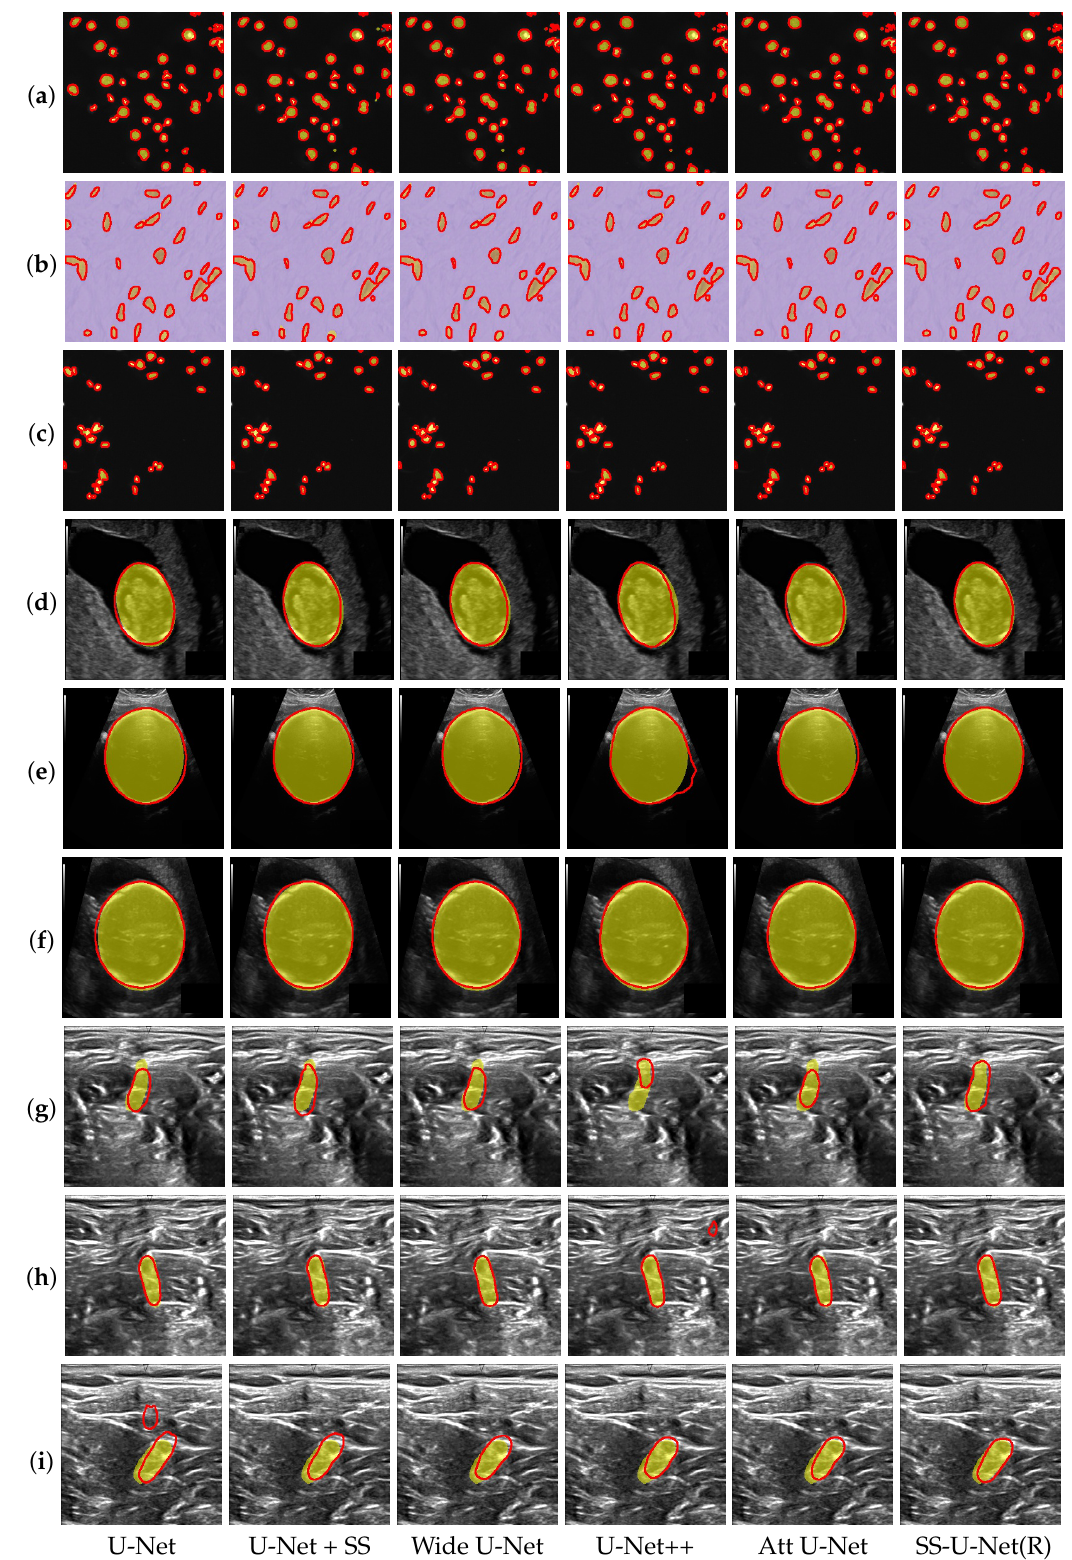
Figure 6. Performance comparison for real medical image segmentation. From top to bottom: the images are test images for three tasks—cell ( a – c ), fetal head ( d – f ), and nerve segmentation ( g – i ), respectively. From left to right: the results are segmented by U-Net, U-Net + SS, Wide U-Net, U-Net++, Att U-Net, and SS-U-Net(R) approaches,